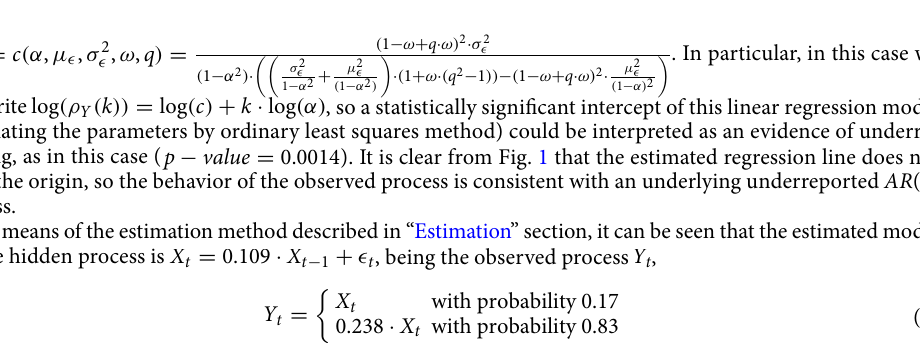
−4.5−4.0−3.5−3.0−2.5−2.0